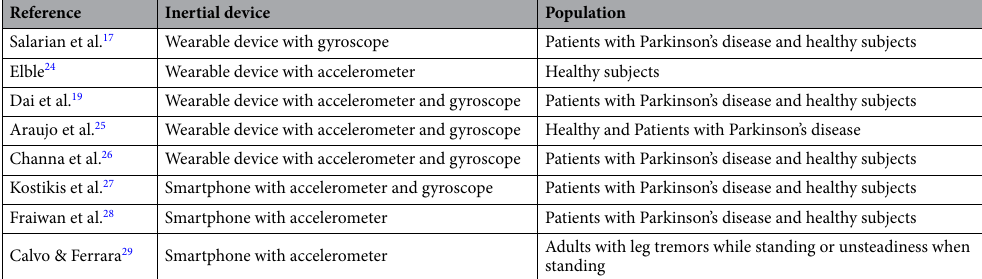
Table 1. List of references that recorded the tremor using accelerometers built-in portable